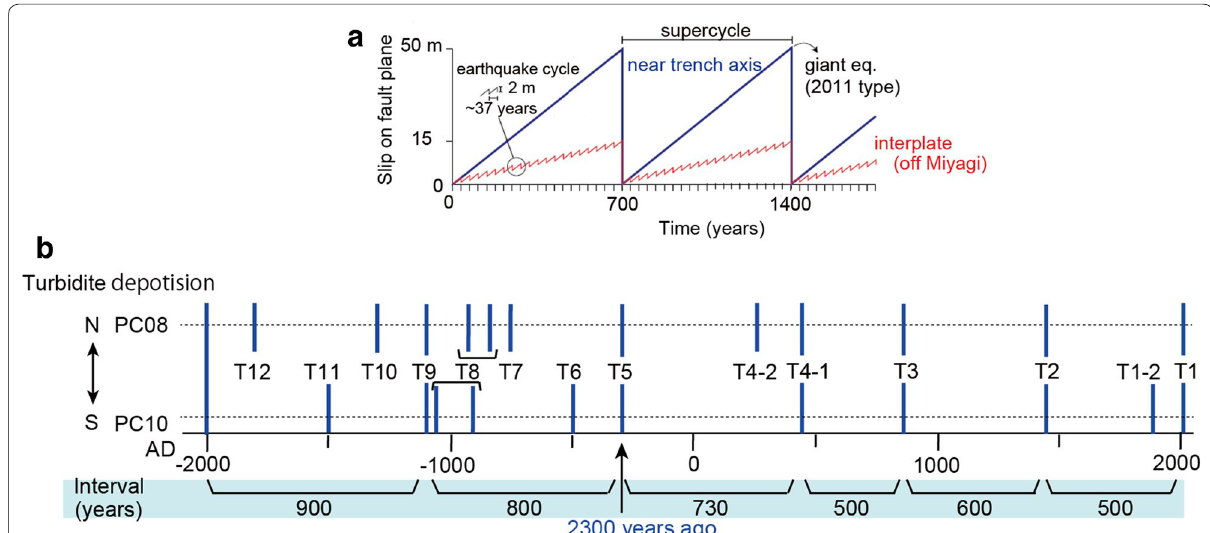
Fig. 4 a Schematic for earthquake supercycle off Miyagi in red and near the trench axis in blue (Satake and Fujii 2014; Satake 2015). If slip accumu- lated from the remainders from off-Miyagi earthquakes is released by giant earthquakes, the recurrence interval or supercycle measures ~ 700 years (Satake 2015). b Time-series diagram for turbidite depositions of NT13-19 PC08 and PC10. Earthquakes related to the supercycle are implied to have occurred for the last 4000 years, and the cycle has become slightly shorter in recent years, considering the concurrent depositional events. The types of earthquakes recorded only in one core have decreased in recent